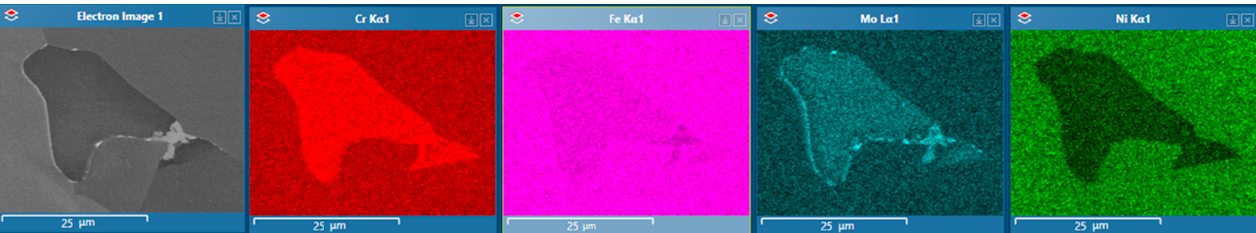
Figure 10. EDS mapping of Build 1 showing the Mo, Cr rich grain, and Mo rich layer.